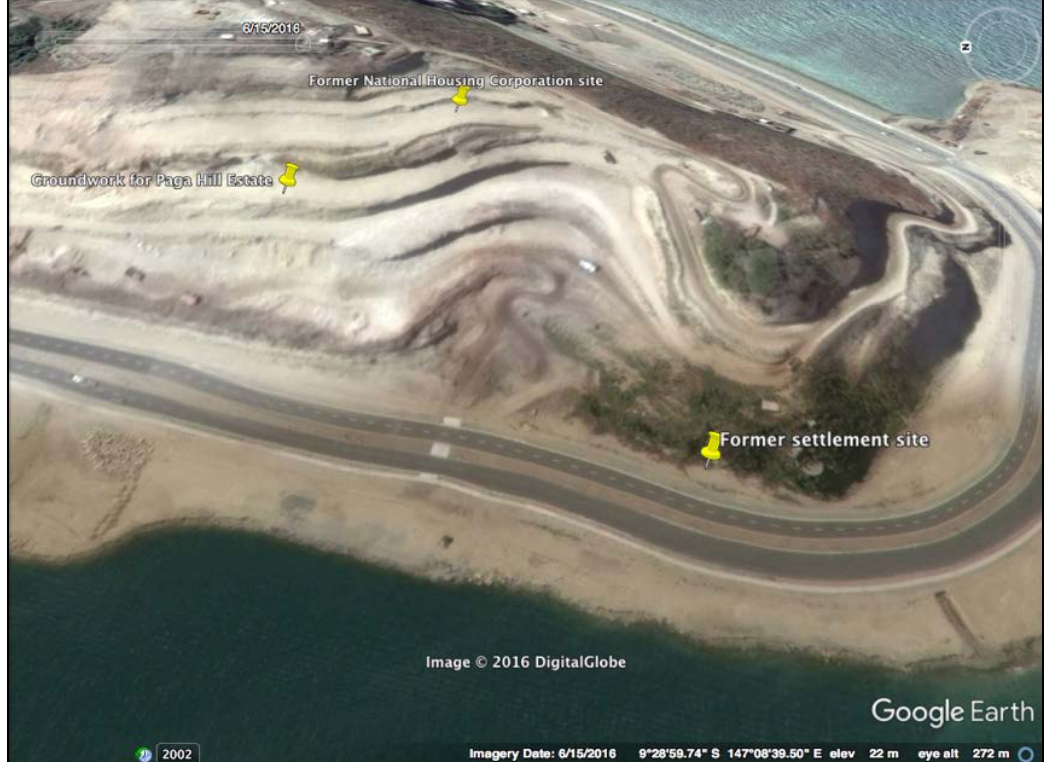
Figure 5: Paga Hill, 15 June 2016 Source: Google